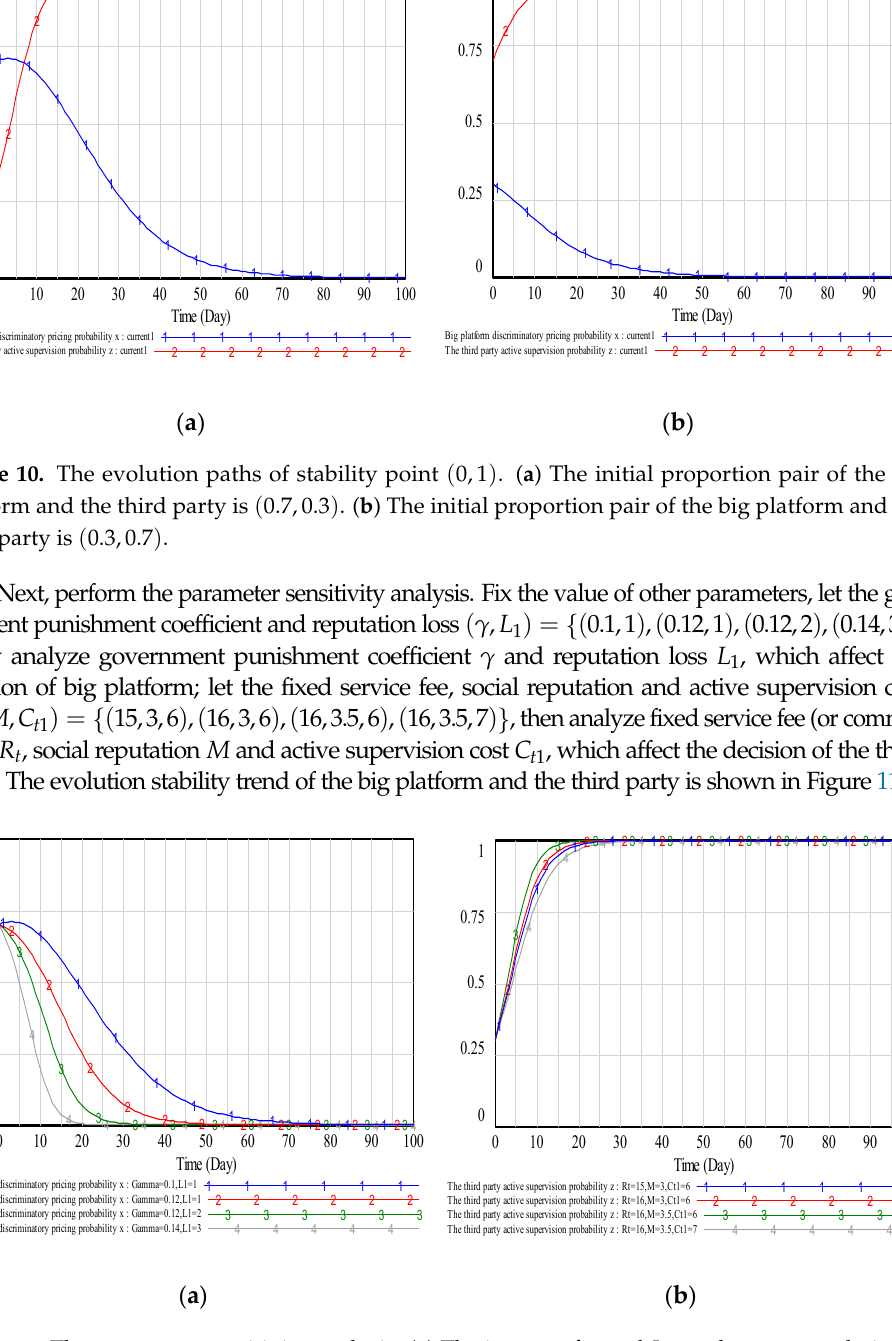
Figure 11. The parameter sensitivity analysis. ( a ) The impact of γ and L 1 on the strategy choice of the big platform. ( b ) The impact of R t , M , and C t 1 on the strategy choice of the third party.